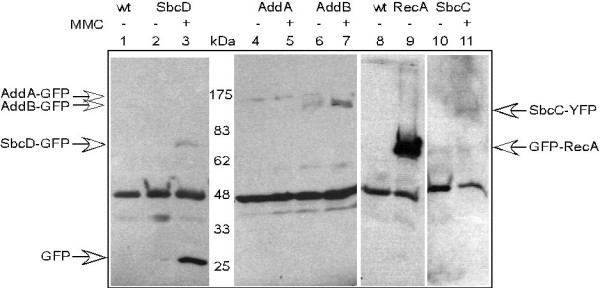
Western blot analysis of B. subtilis cells using anti-GFP antiserum. Lane 1: PY79, exponential growth, lanes 2 and 3: JN4 (sbcD-gfp), lane 2 exponential growth, lane 3 one hour after addition of MMC (100 ng/ml), lanes 4 and 5: JN7 (addA-gfp), lane 4 exponential growth, lane 5 one hour after addition of MMC, lanes 6 and 7: JM41 (addB-yfp), lane 6 exponential growth, lane 7 one hour after addition of MMC, lane 8: PY79, lane 9: DK39 (gfp-recA), lanes 10 and 11: JN6 (sbcC-yfp), lane 10 exponential growth, lane 11 one hour after addition of MMC. The same amount of protein was loaded in each lane. Arrows indicate the position of fusion proteins and of free GFP. AddA-GFP: 169 kDA, AddB-YFP: 162 kDa, SbcC-YFP: 153 kDa, SbcD-GFP: 71 kDa, GFP-RecA: 66 kDa, GFP: 28 kDa. Note that the antiserum strongly cross reacts with a protein of about 48 kDa.